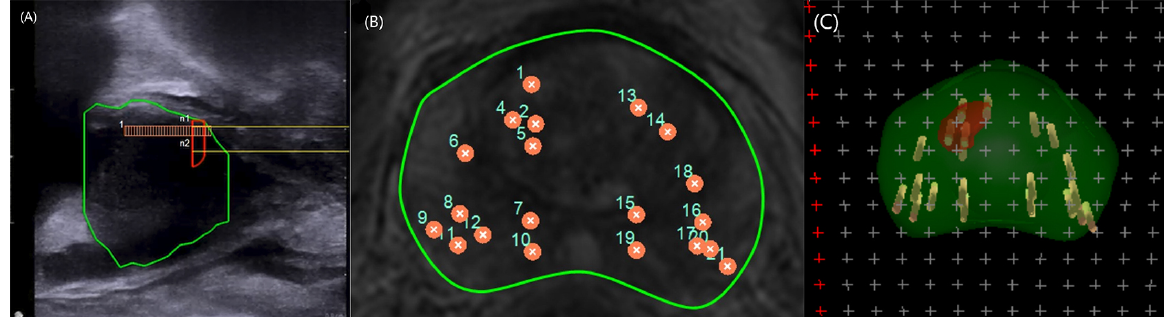
Fig. 1. Record of biopsy trajectory. A sagittal view of ultrasound revealed a biopsy trajectory through the target lesion (A). All targeted and systematic biopsy trajectories were recorded on a 2-D or 3-D model